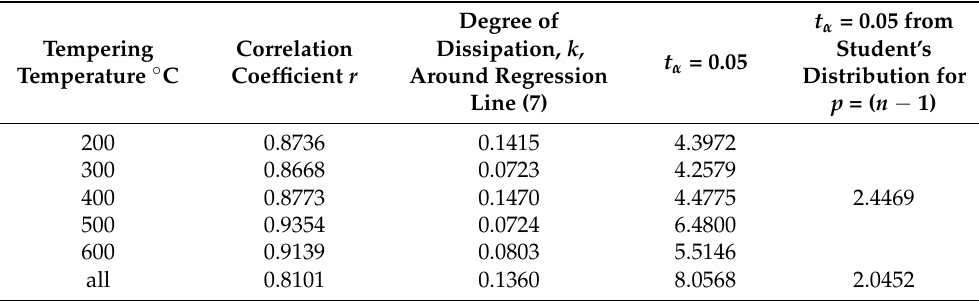
Table 6. Statistical parameters representing mathematical Equation (6), correlation coefficients and dissipation.